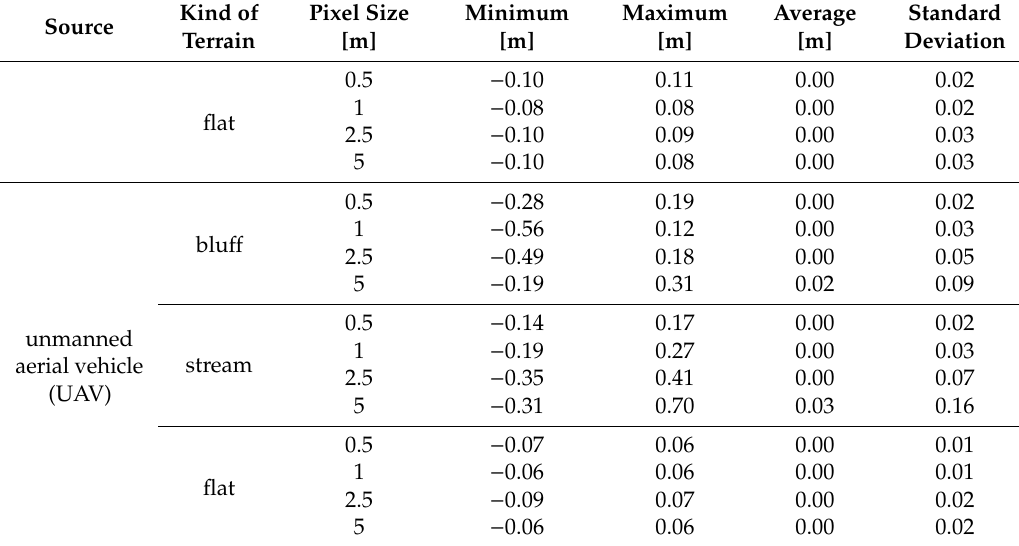
Table 3. Parameters of the analyzed vehicles [55–57].